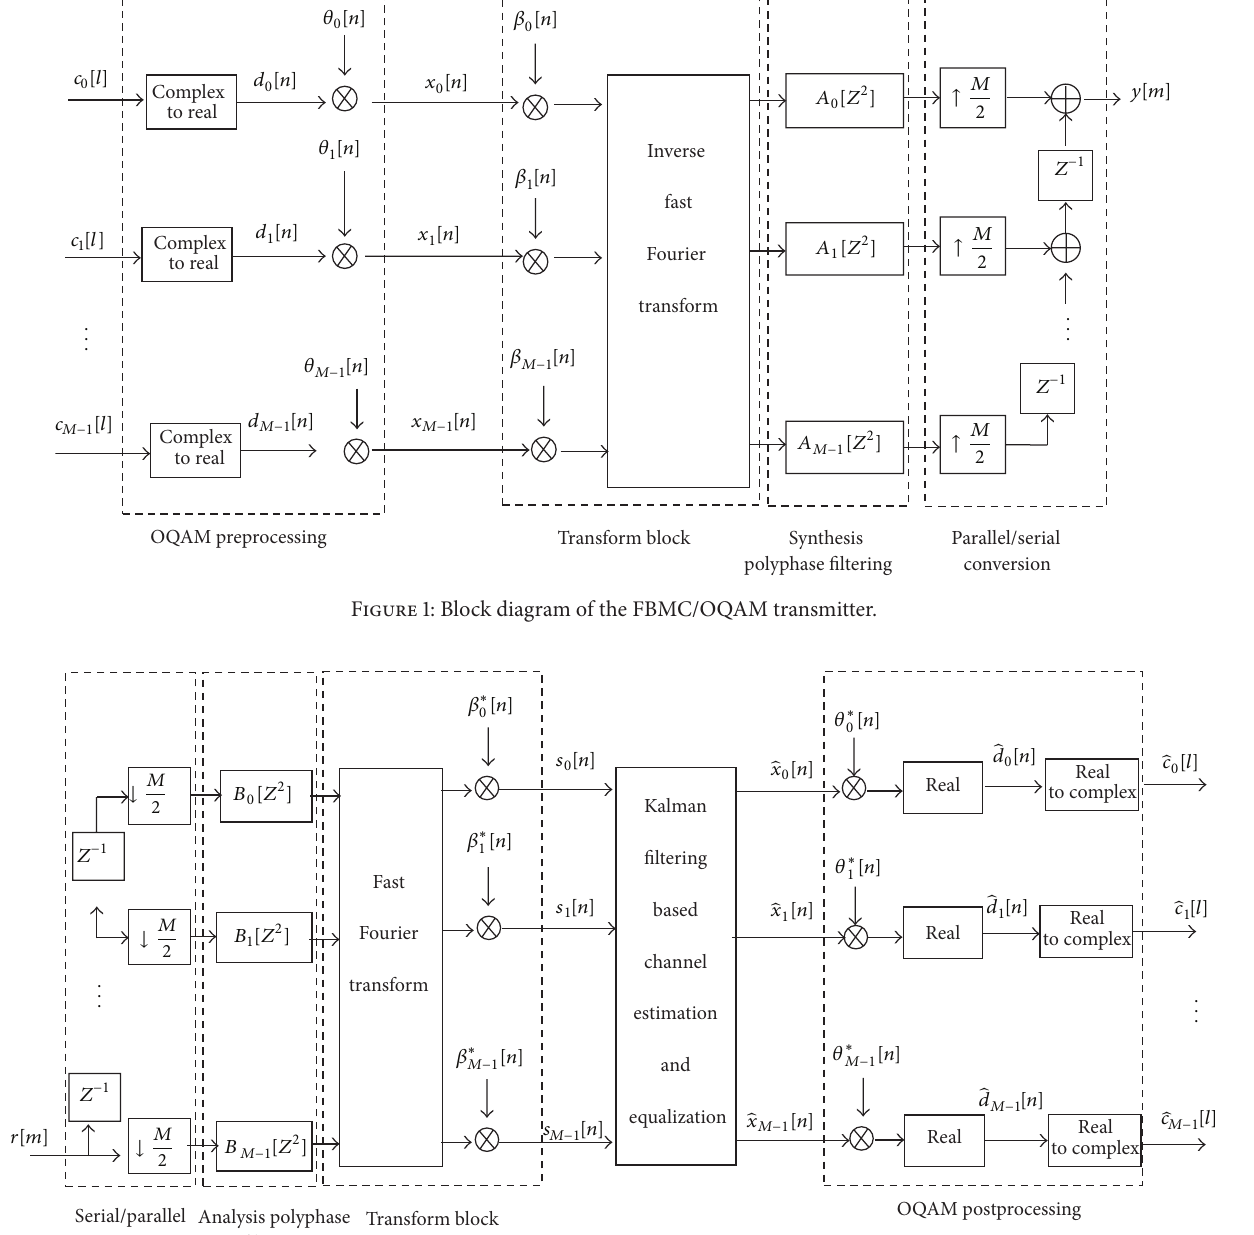
Figure 2: Block diagram of the FBMC/OQAM